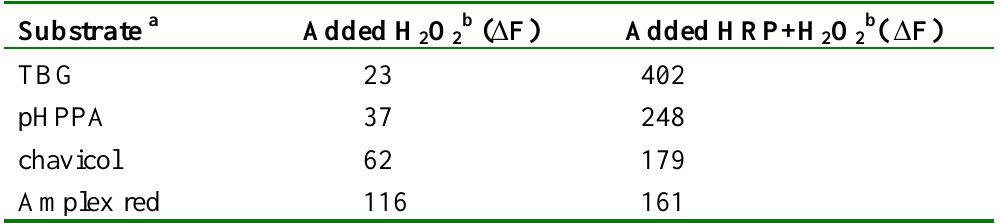
O or HRP-BrAb + H 2 2